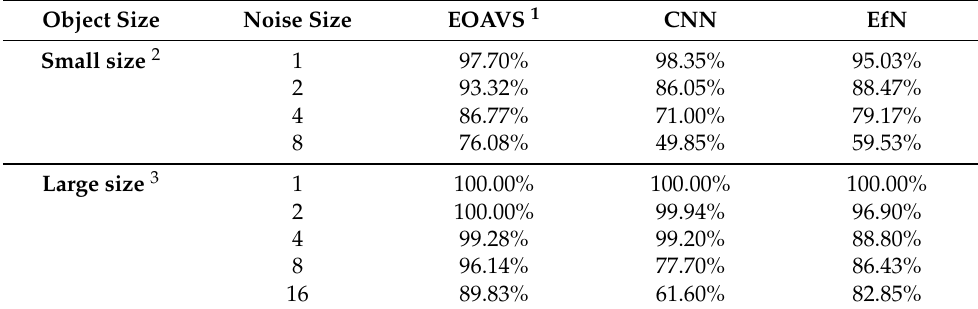
Table 3. Edge noise accuracy.